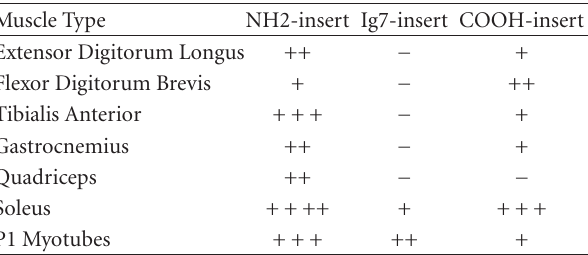
Table 1: Tabulated summary of the RT-PCR data shown in Figure 2. The plus (+) and minus ( − ) signs denote the presence or absence of mRNAs encoding the three regions of interest, respectively; the relative abundance of the respective transcripts is illustrated by the number of plus